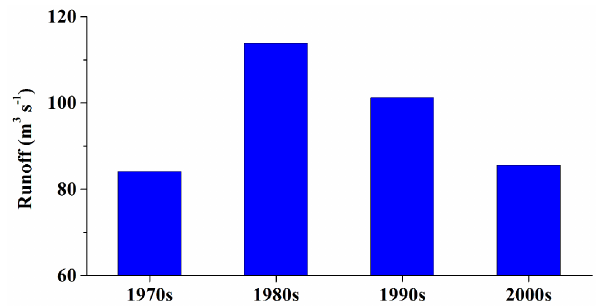
Figure 8. Variation in mean annual surface runoff at the decadal scale in the Jinghe River basin from the 1970s to the 2000s.